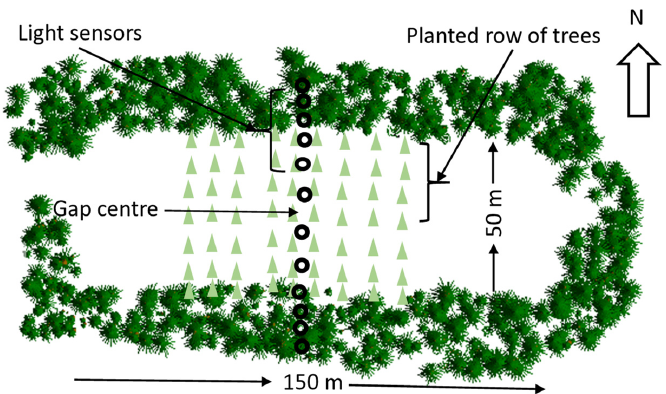
Figure 1. An illustration of the general experimental layout for one strip-cut, showing a 50 m × 150 m clearing surrounded by uncut stands, planting rows and placement of light sensors. Trees were planted in single-species, north-south oriented rows, with each row 90 m long extending 20 m into the uncut stand south and north of the edge of each harvested block. Species rows were allocated randomly in an east-west direction, with three replica- tions (three rows per species) in each block. Row-to-row spacing was 2.6 m and within each row seedlings were planted at a 3 m spacing. A 20-m wide unplanted buffer was